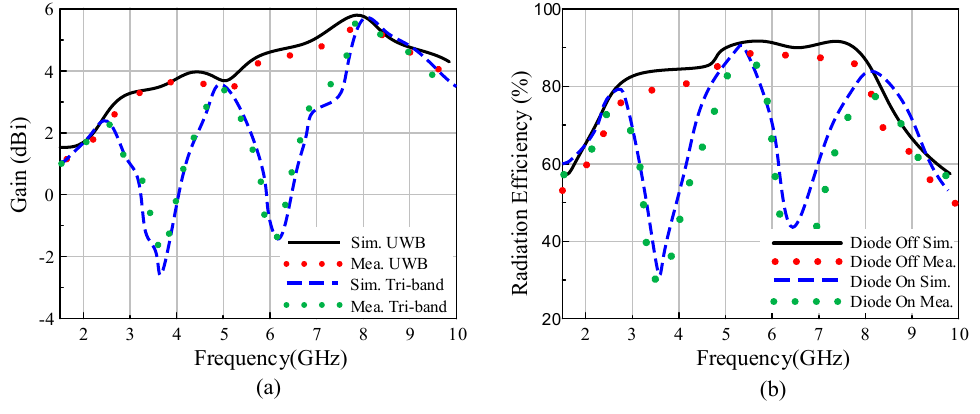
Figure 13. ( a ) Gain and ( b ) radiation efficiency of the proposed antenna.